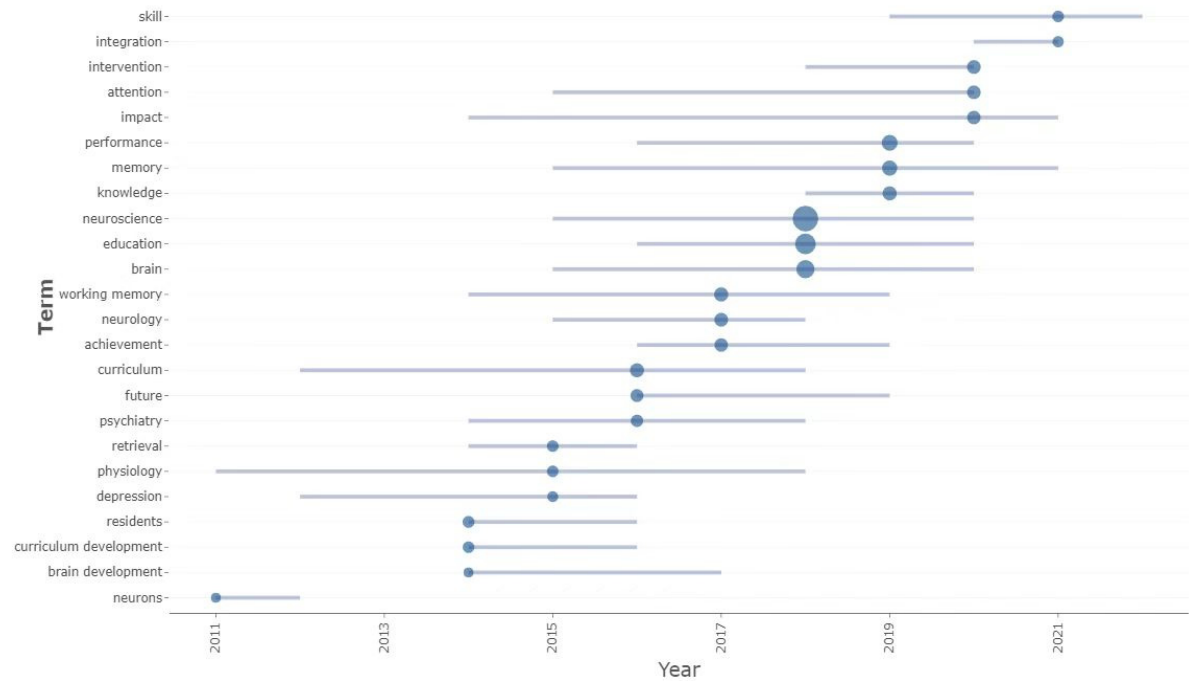
Figure 9. Theme evolution